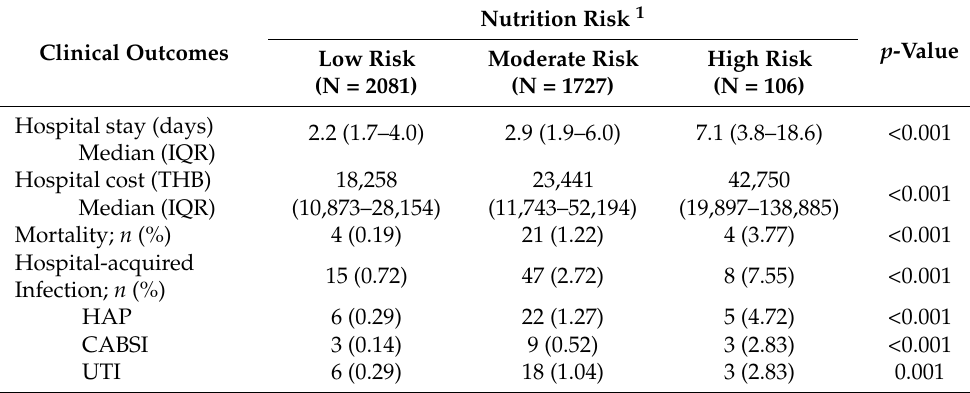
Table 2. Comparisons of clinical outcomes by nutrition risk classi fi cation.